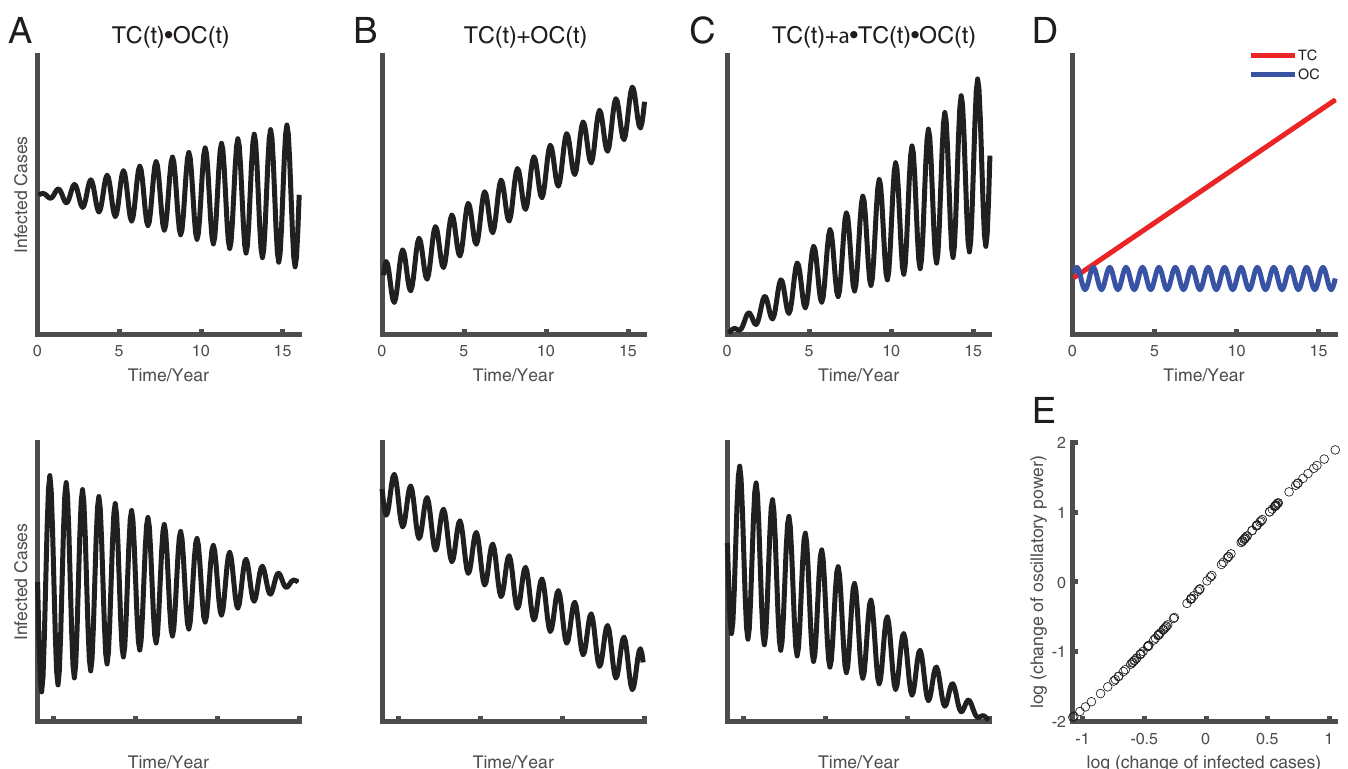
Fig 4. The conceptual hybrid model to illustrate the oscillatory mechanism. Three hypotheses are shown in A-C. Plot A illustrates the multiplication mechanism of tendency component (TC) and oscillatory component (OC). Plot B illustrates the additive mechanism. Plot C illustrates the hybrid mechanism. Plot D is an example of of TC and OC. E shows the result of a simulation based on the hybrid mechanism, which is consistent with results of real datain Fig 3C.